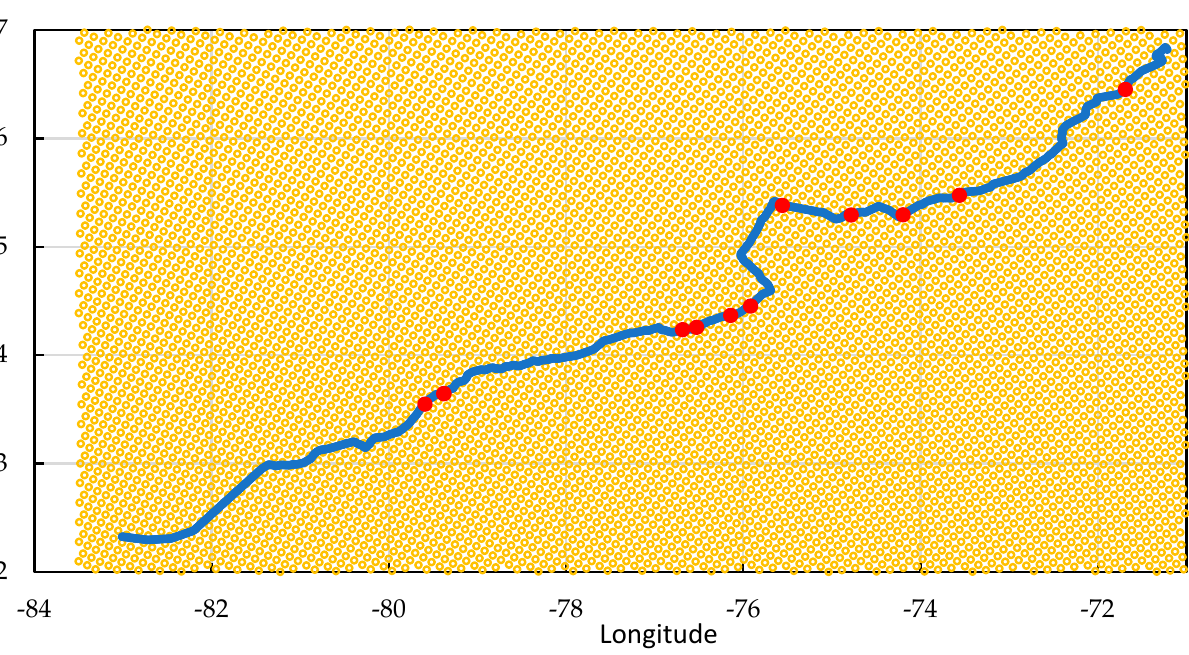
Figure 3. Location of 6640 reference points (orange dots), 1300 interpolation points (blue dots) on the railroad, and 12 evaluation points (red dots).